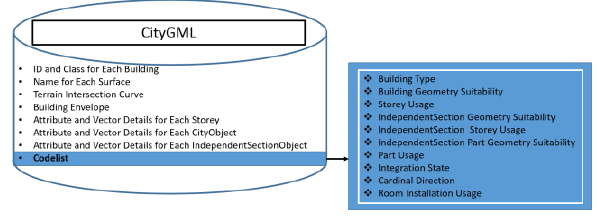
Figure 4. Contents of CityGML